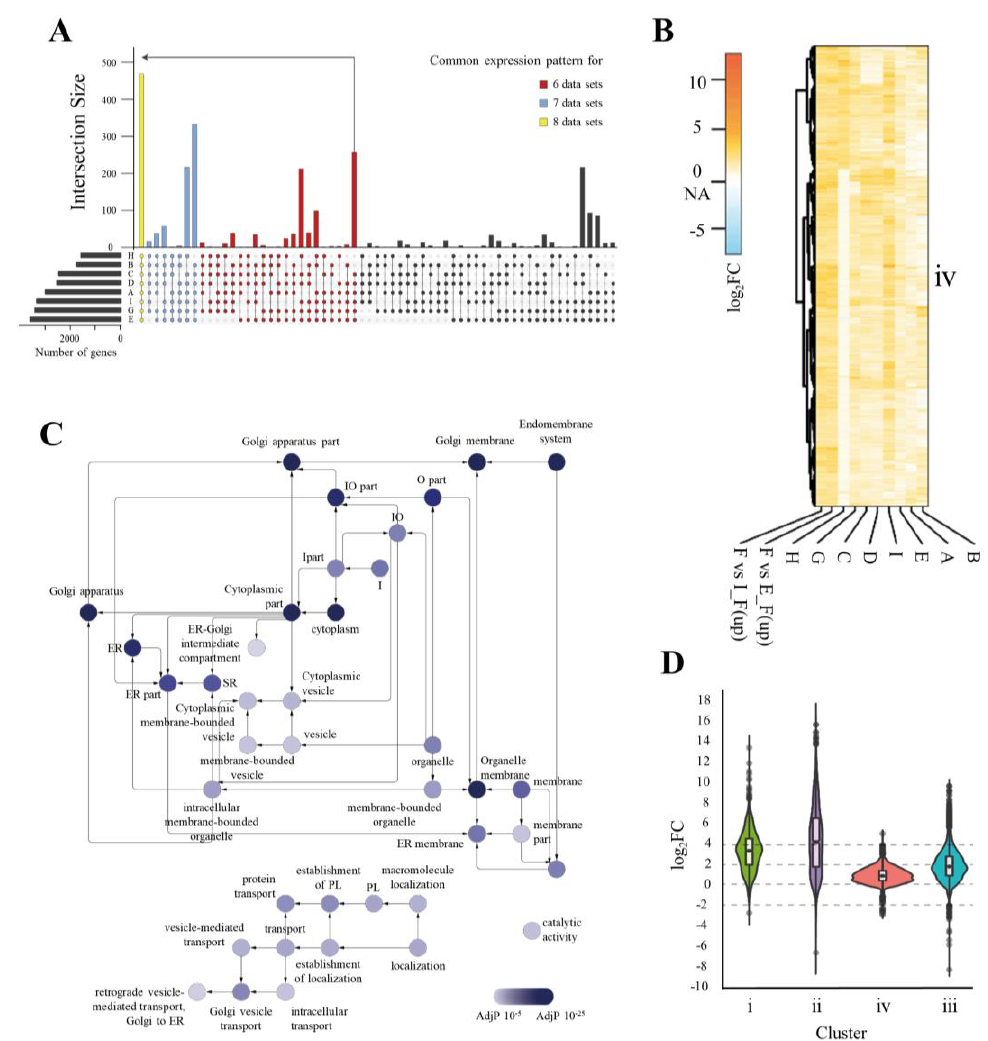
Figure 2. Gene expression analysis of hPSCs and fibroblasts. ( A ) UpsetR plot showing downregulated genes in hPSCs in eight datasets. The left bar graph shows the number of genes used in the intersection for each dataset. The color-filled plots show the number of commonly downregulated genes. Genes commonly downregulated in six, seven, and eight datasets are colored with red, light blue and yellow, respectively. The GEO data used are abbreviated as follows; A: GSE54186, ESC (H1) vs differentiated fibroblasts; B: GSE54186, ESC (H9) vs differentiated fibroblasts; C: GSE33298, ESC vs fibroblasts; D: GSE33298, induced pluripotent stem cells (iPSC) vs fibroblasts; E: IPSC vs fibroblasts; G: GSE24487, IPSC vs fibroblasts; H: GSE24487, ESC vs fibroblasts; I: GSE20750, IPSC vs fibroblasts; ( B ) Heat-map showing the log 2 FC-fold change value for the four generated clusters. The orange color key indicates the fold-changes of downregulated genes in hPSCs and blue color indicates the fold-changes of upregulated genes in fibroblasts. ( C ) Gene ontology (GO) network of cluster iii that satisfies a cutoff of FDR < 0.00001 for hypergeometric test with FDR correction using BiNGO which is a Java-based tool to determine GO. The darker blue-colored mapping indicates stronger enrichment. Abbreviations: endoplasmic reticulum: ER; intracellular: I; organelle: O; sub-synaptic reticulum: SR; protein localization: PL. ( D ) Violin plot showing the fold change pattern distribution of each cluster generated from the heat-map.